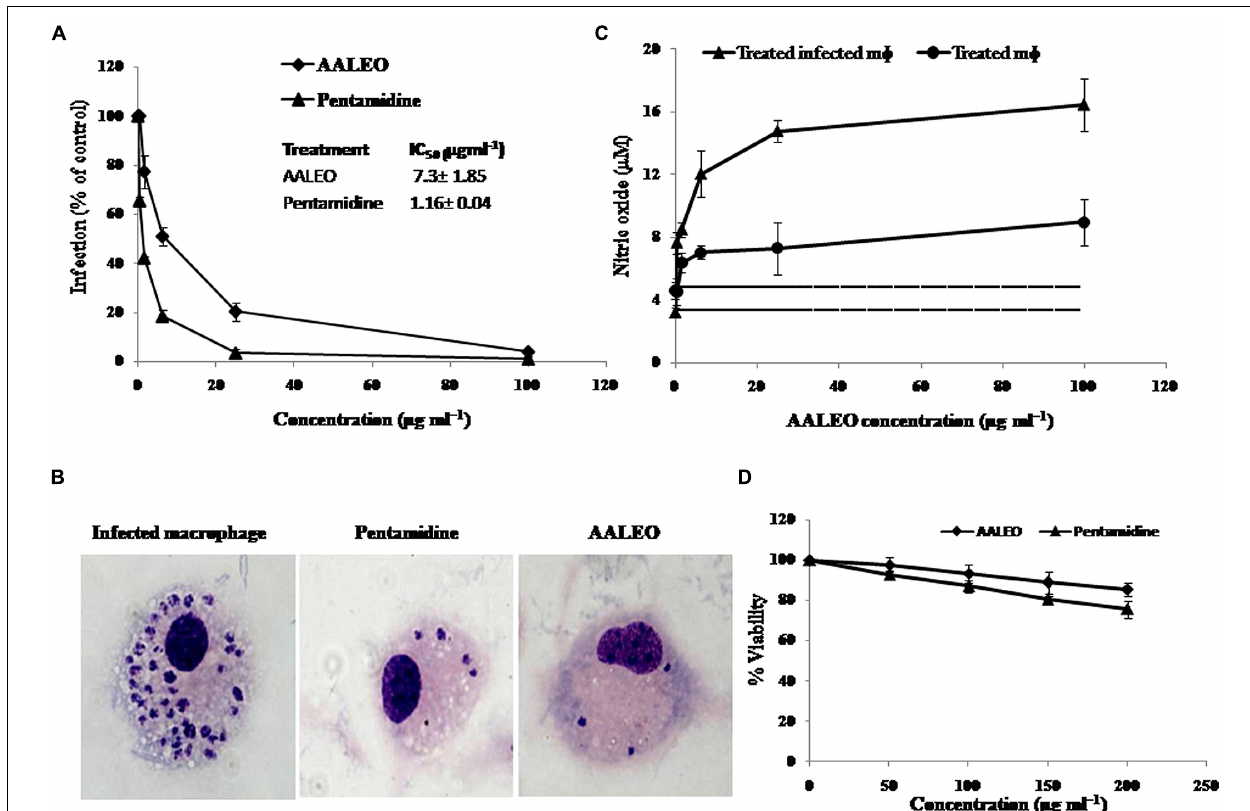
FIGURE 2 | Effect of AALEO on L. donovani intracellular amastigote forms. Promastigote-infested RAW 264.7 macrophages were incubated at 37 ◦ C in a CO 2 incubator with serial fourfold dilutions of AALEO (starting at 100 μ g ml − 1 ) for 48 h. (A) % infectivity estimated for determination of IC 50 on amastigotes (inset) (B) Micrographs of giemsa-stained infected macrophages upon treatment (100 × ) (C) NO generation by uninfected (filled circle) or infected (filled triangle) macrophages post-incubation with